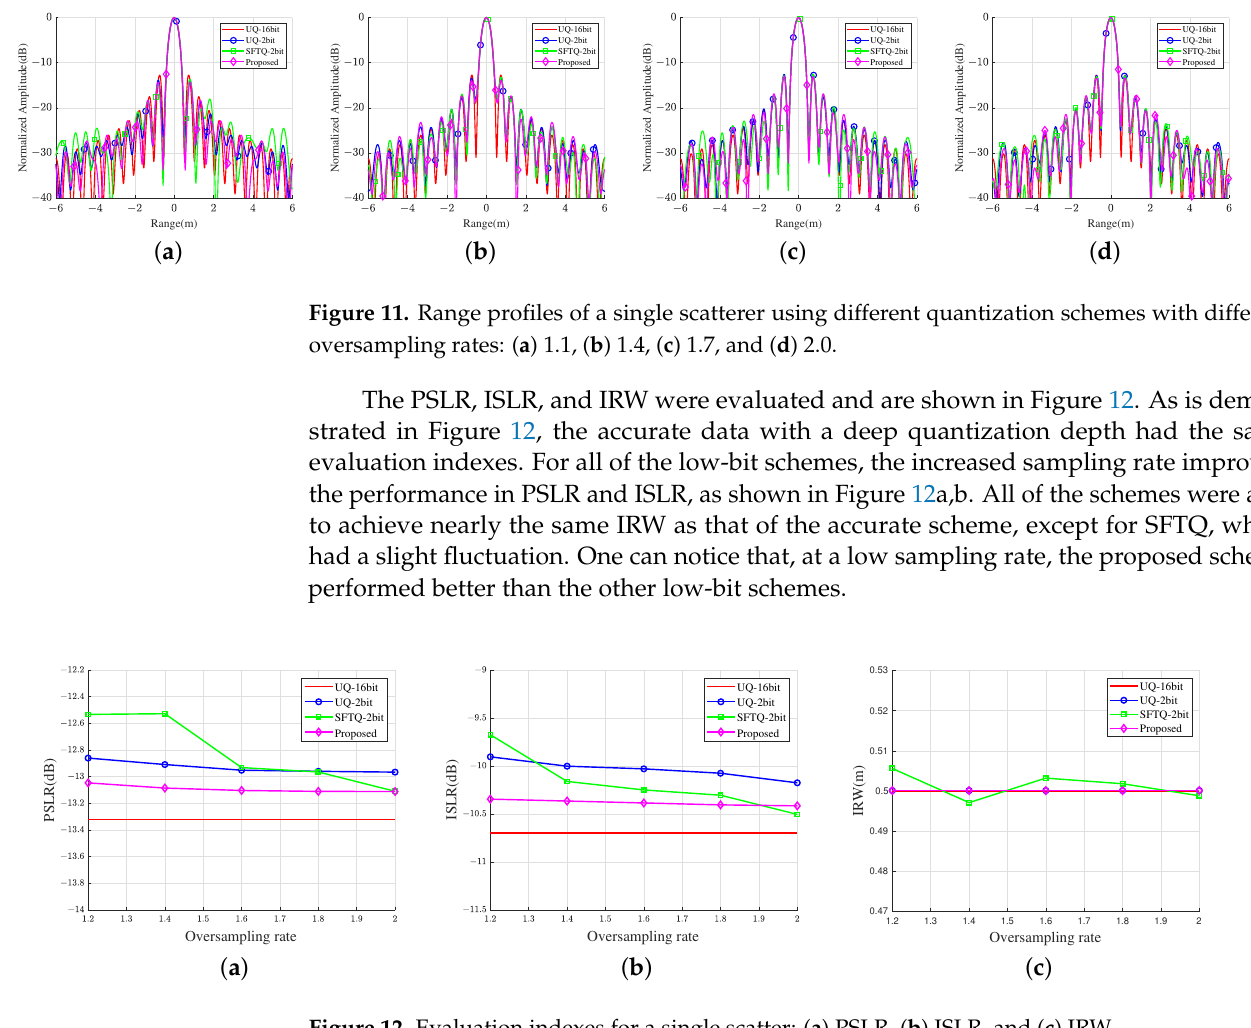
Figure 12. Evaluation indexes for a single scatter: ( a ) PSLR, ( b ) ISLR, and ( c )